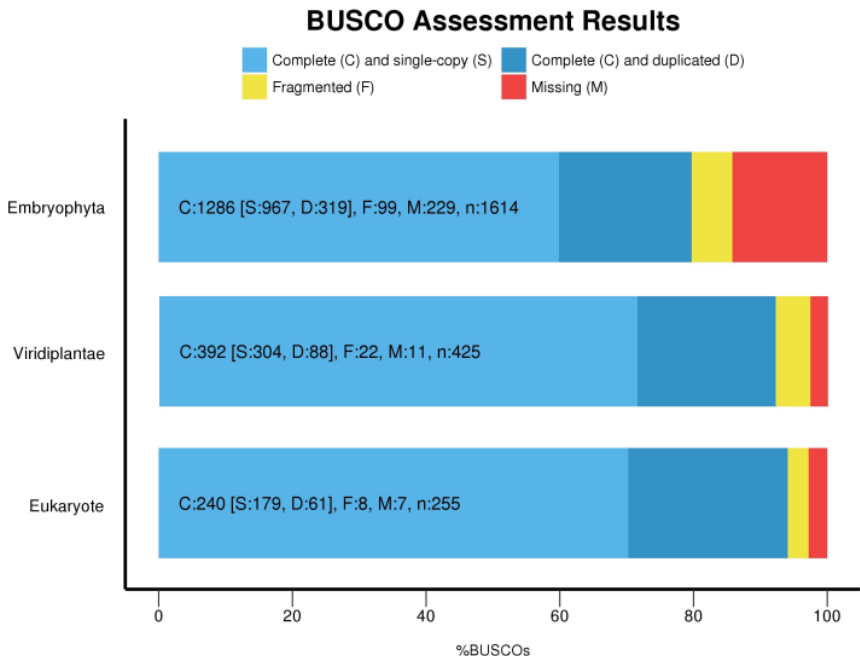
Figure 1. BUSCO completeness assessments of the V. speciosa filtered transcriptome with the Eukar- yote ( n = 255 conserved genes), Viridiplantae ( n = 425 conserved genes) and Embryophyta ( n = 1614 conserved genes) datasets. Blue, yellow, and red bars, respectively, represent the proportion of com- plete (C), fragmented (F), and missing (M) BUSCO genes. Light blue bars represent complete and single-copy BUSCO genes (S). Dark blue bars represent complete and duplicated BUSCO genes (D). Numbers within bars are absolute numbers of recovered (complete or fragmented) and missing genes. For example, for Embryophyta, the total dataset is composed of n = 1614 genes, of which 1286 (79.7%) were complete, 99 (6.1%) were fragmented, and 229 (14.2%) were not recovered. Among the complete genes, 319 represented duplicated genes and 967 represented single-copy genes.